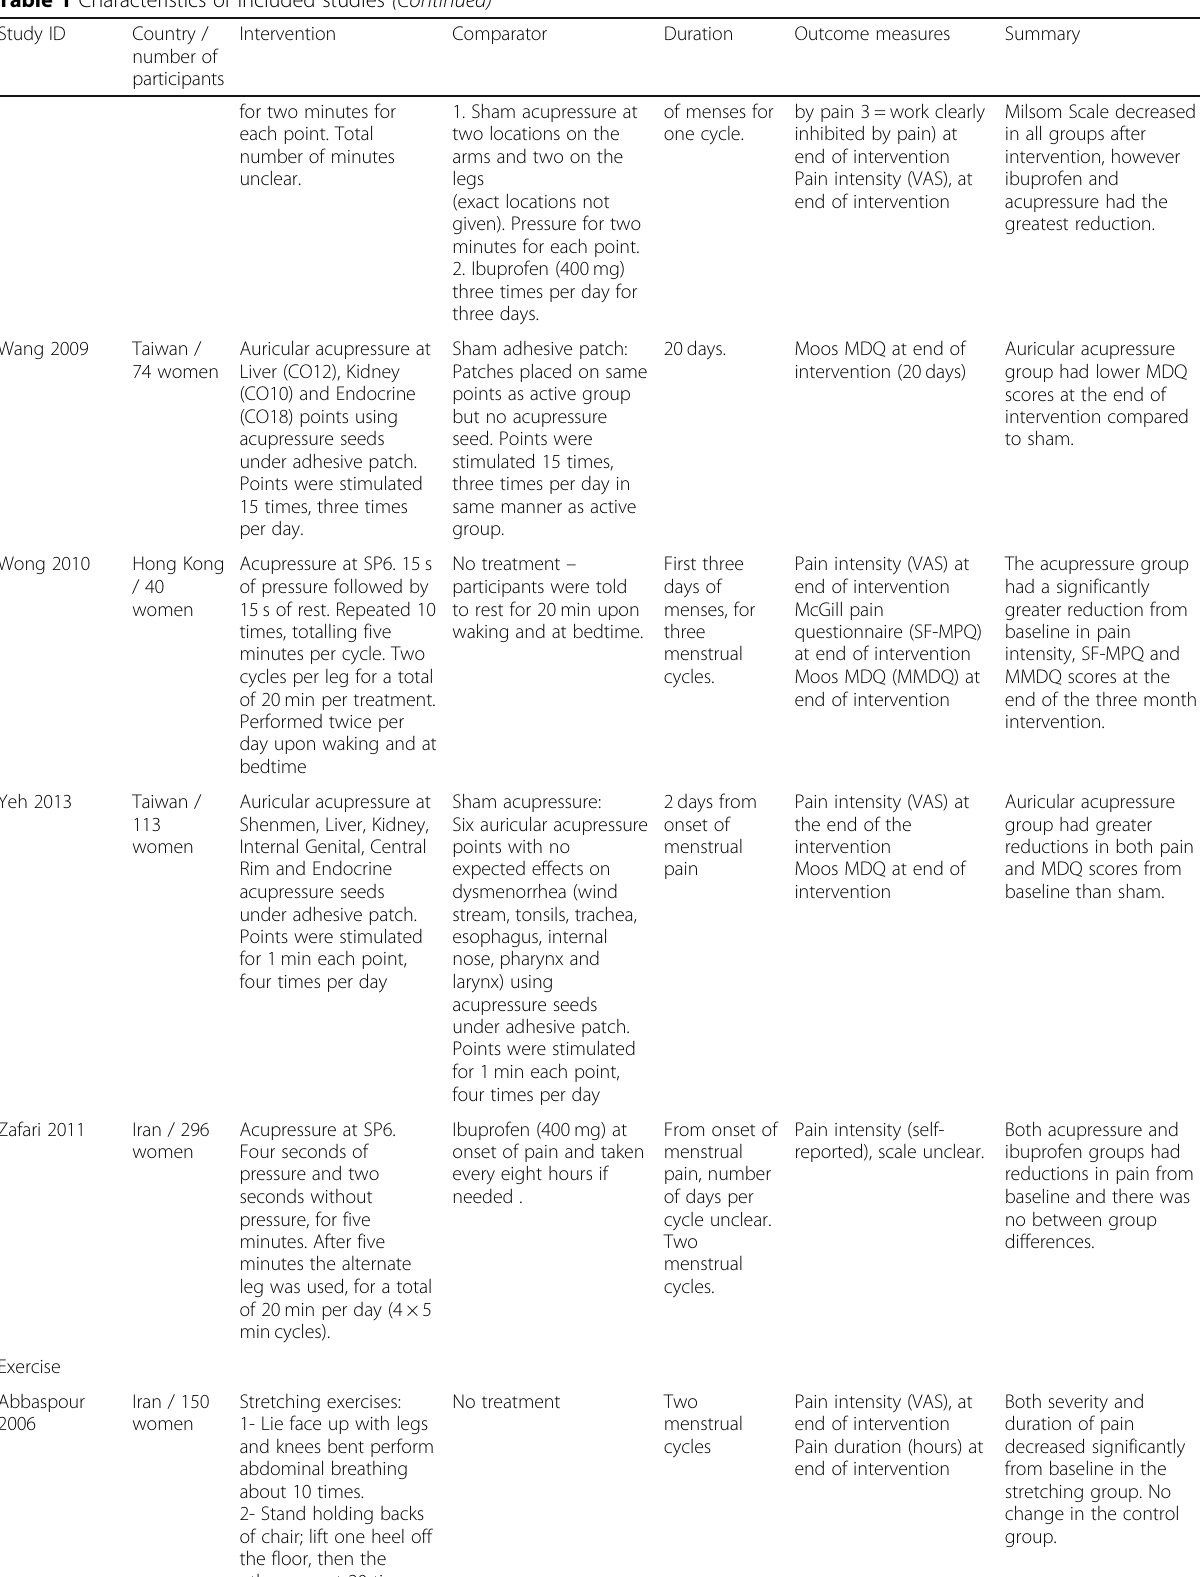
Table 1 Characteristics of included studies